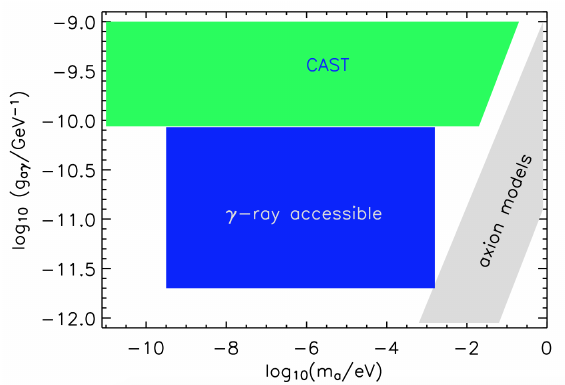
Figure 4. ALPs parameter space available for gamma-ray observations. Reprinted from Hooper and Serpico